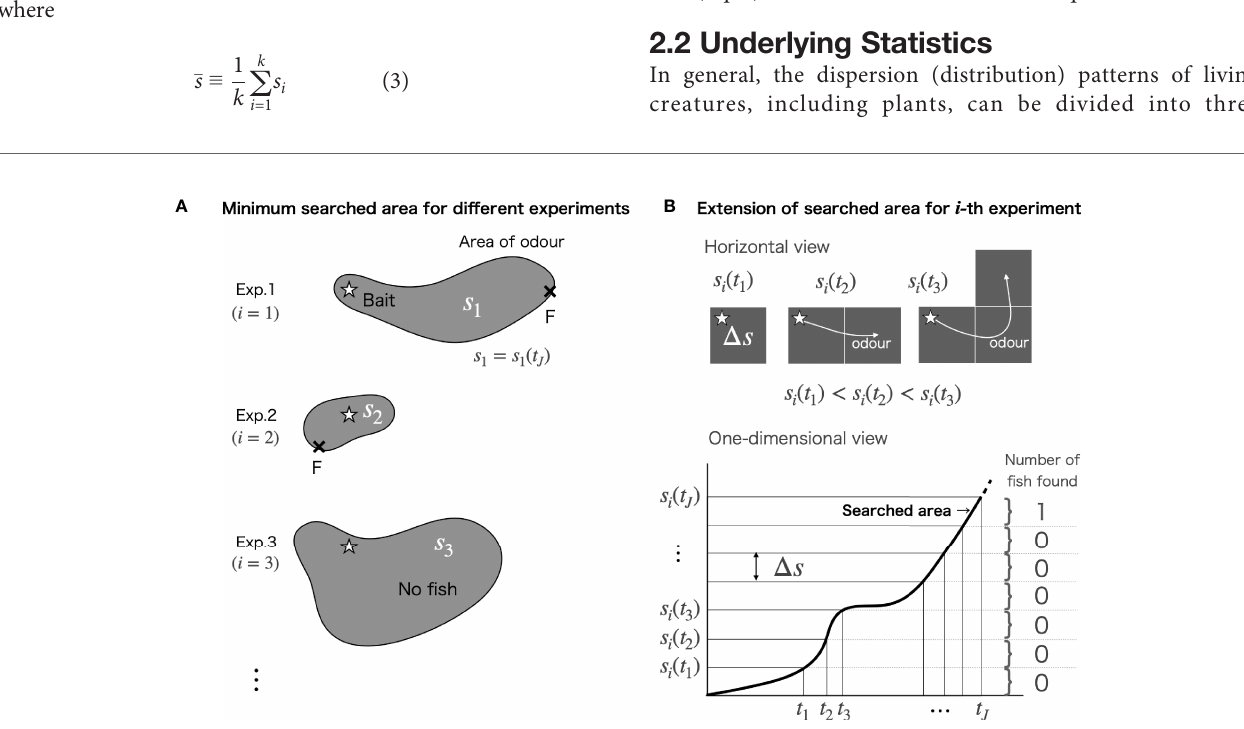
FIGURE 1 | (A) Sketch of the experiment to produce the minimum searched area. The cross symbol with “ F ” denotes the position of the fi sh that searched fi rst. (B) Schematic illustration of the extension rule of the searched area in horizontal (upper) and one-dimensional views (lower). The grey squares denote the searched area. The stars in panels (A , B) denote the location of the baited